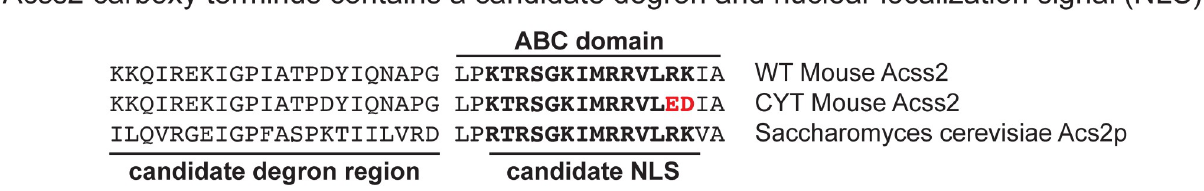
Fig 6. Acss2 protein levels are markedly reduced in ED Acss2 mouse embryonic fibroblasts. (A) Immunofluorescent and (B) immunoblot analyses of mouse embryonic fibroblasts (MEF) (two independently derived cell lines; normalized to protein amount and compared to immunoblot of α -tubulin) derived from ED Acss2 pups reveal undetectable Acss2 protein levels. Acss2 immunoreactivity is noted in the cytosol as well as nucleus of WT MEF as evident by colocalization of Acss2 signal (red) with nuclei stained with DAPI (blue). (C) Acss2 mRNA levels in ED MEF are not significantly reduced relative to Acss2 mRNA levels in WT MEF (n = 3 per group, P = 0.259).